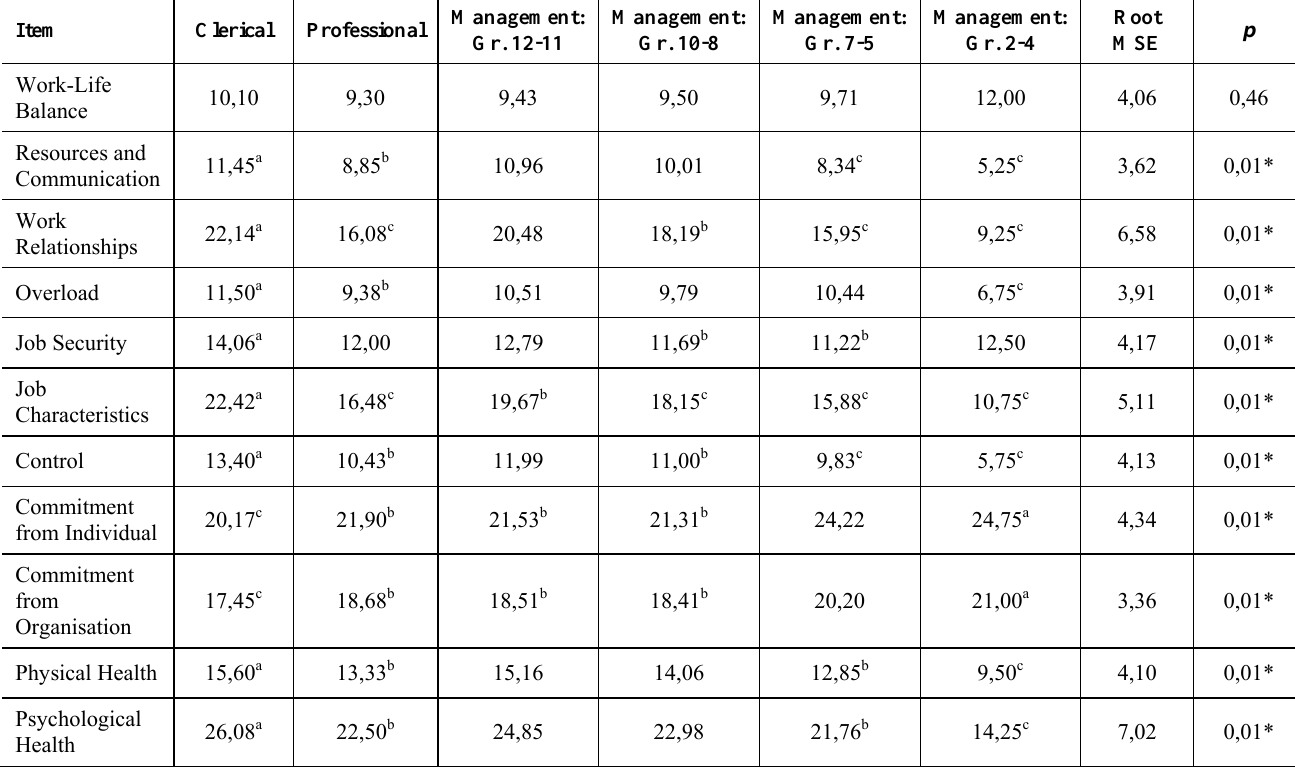
Table 3: ANOVAs – Differences in stress, organisational commitment and ill health of different job categories Item